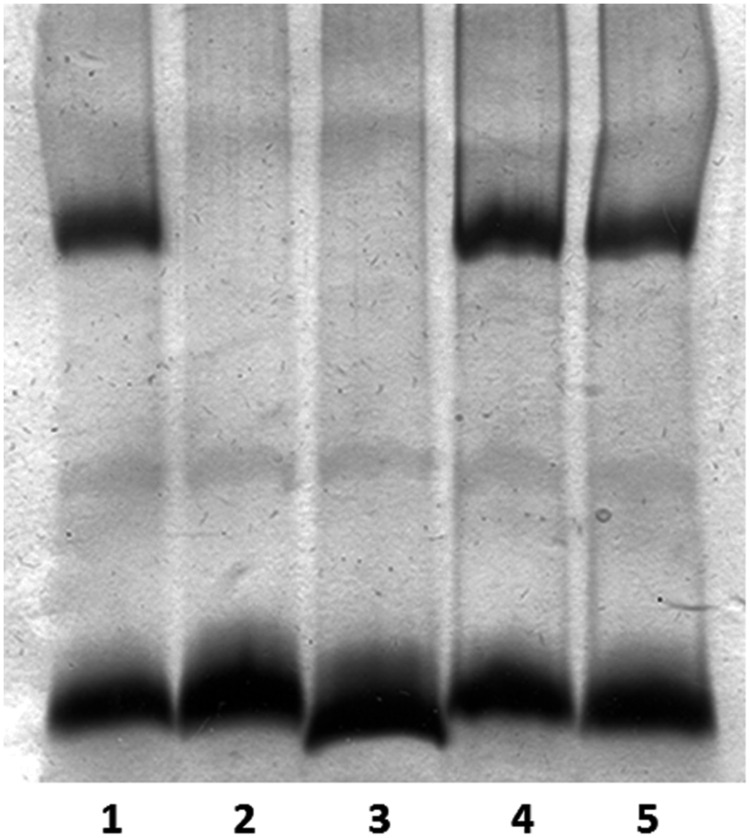
Lipopolysaccharide (LPS) analyzed by SDS-Tricine gel and silver stained for A. hydrophila strains: AH-1 wild-type (lane 1), AH-1ΔrmlB mutant (lane 2), AH-1ΔwahD mutant (lane 3), AH-1ΔrmlB mutant complemented with pBAD-rmlB (lane 4), and AH-1ΔWahD mutant complemented with pBAD-wahA (lane 5).